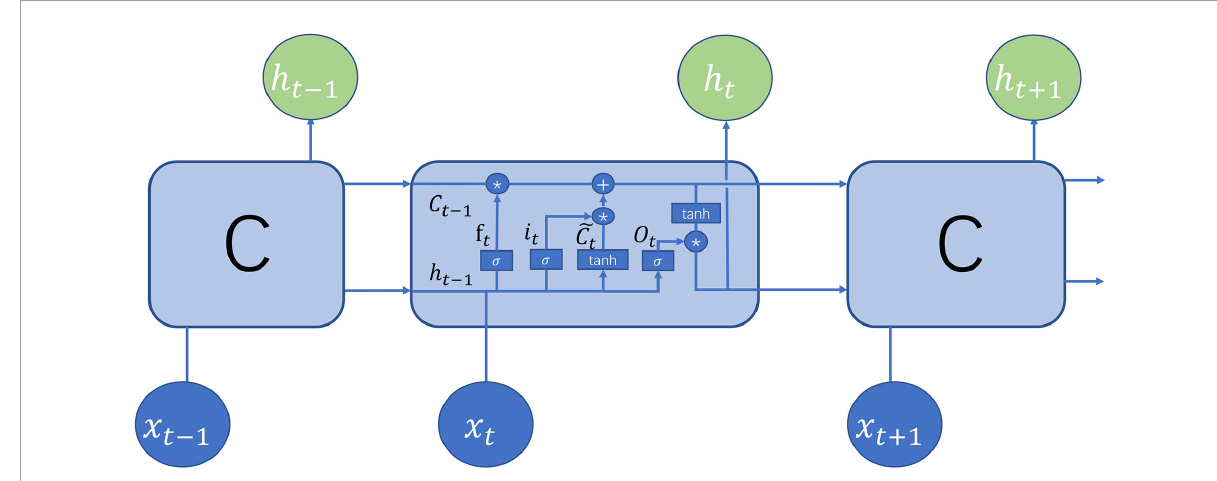
FIGURE2 Illustration of long short-term memory (LSTM) structure (Olah,